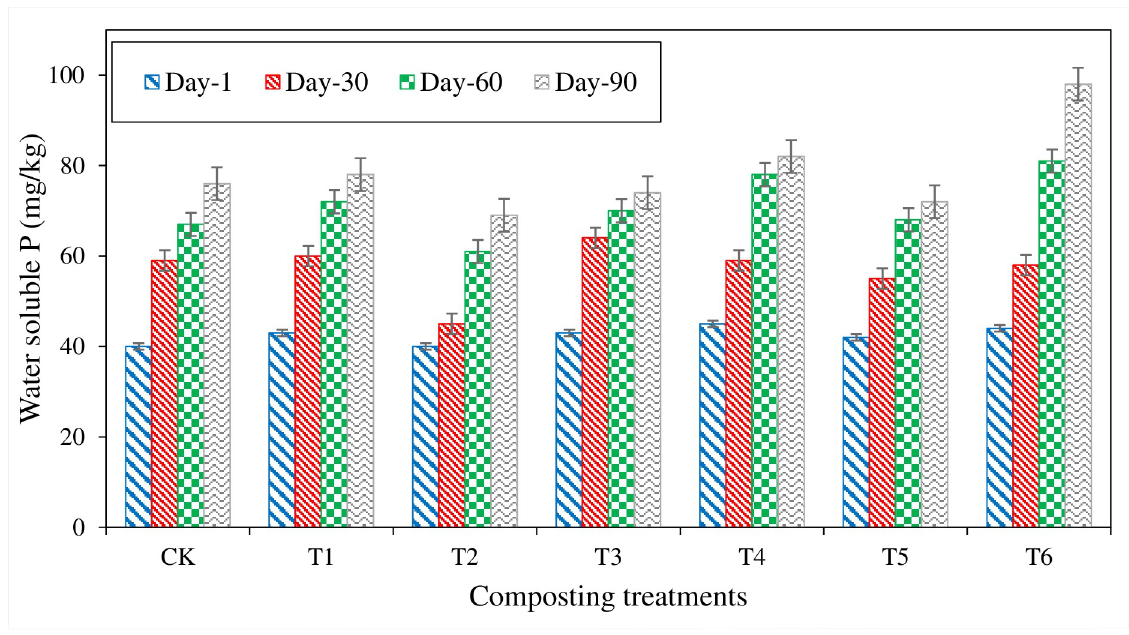
Fig 8. Water-soluble P (WSP) measured from different composting treatments.